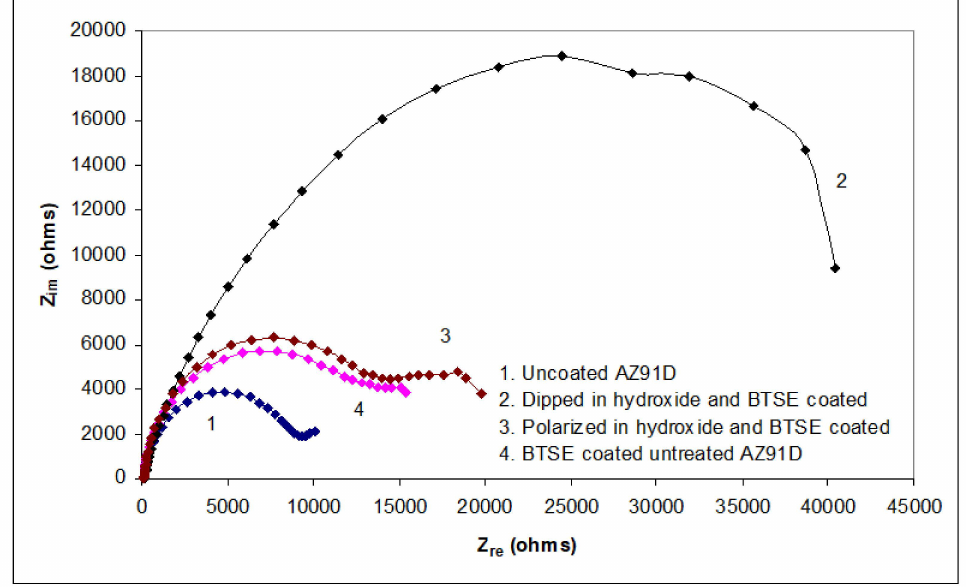
Figure 3. Nyquist plots for AZ91D in 0.1 M NaCl solution: (1) uncoated, (2) pre-dipped in hydroxide for 48 h and BTSE coated, (3) pre-polarized in hydroxide and BTSE coated, and (4) BTSE coated without any pre-treatment. Z im and Z re stand for imaginary and real impedances